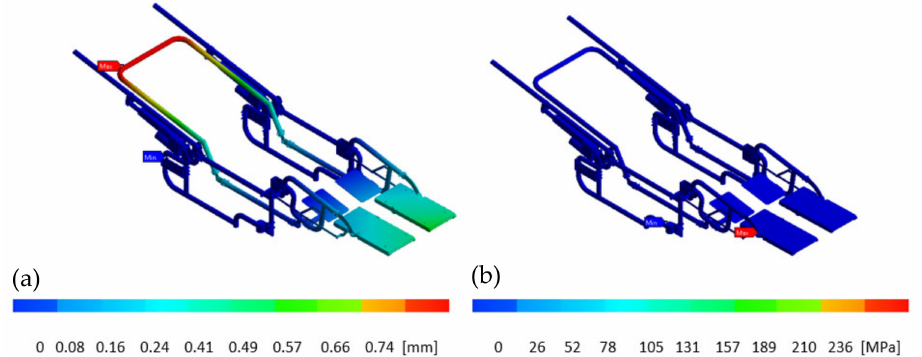
Figure 10. Wheelchair FEM analysis; ( a ) Deformation, ( b ) Von mises stress